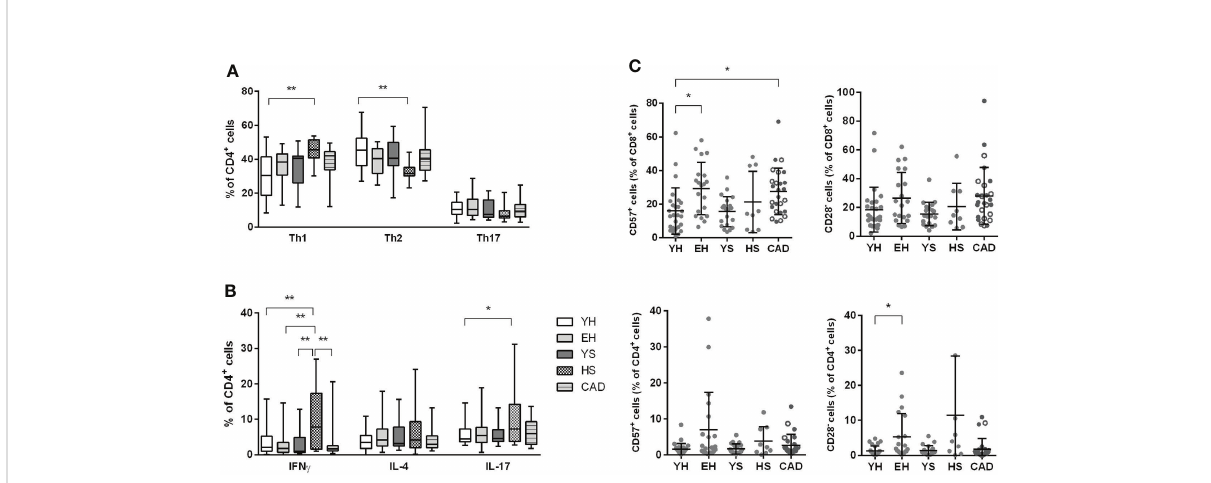
FIGURE 5 Effect of ageing and smoking on Th subsets and T cell senescence. Percentage of Th1 (CXCR3 + CCR6 - ), Th2 (CXCR3 - CCR6 - ) and Th17 (CXCR3 - CCR6 + ) cells were measured by fl ow cytometry (A) . Cytokine production in CD4 + T cells was measured after stimulation with PMA + ionomycin in the presence of BrefA, using fl ow cytometry (B) . Both CD4 + as well as CD8 + T cells were assessed for senescence markers CD57 (positive) and CD28 (negative) (C) . YH = young healthy, EH = elderly healthy, YS, young smoker; HS, heavy smoker; CAD, coronary artery disease patient. Open circles in the CAD group represent smokers. Statistics was performed using one-way ANOVA with Dunnett ’ s post hoc test, means were compared to the YH group. P values ≤ 0.05 are considered signi fi cant. * p ≤ 0.05, ** p ≤ 0.005.